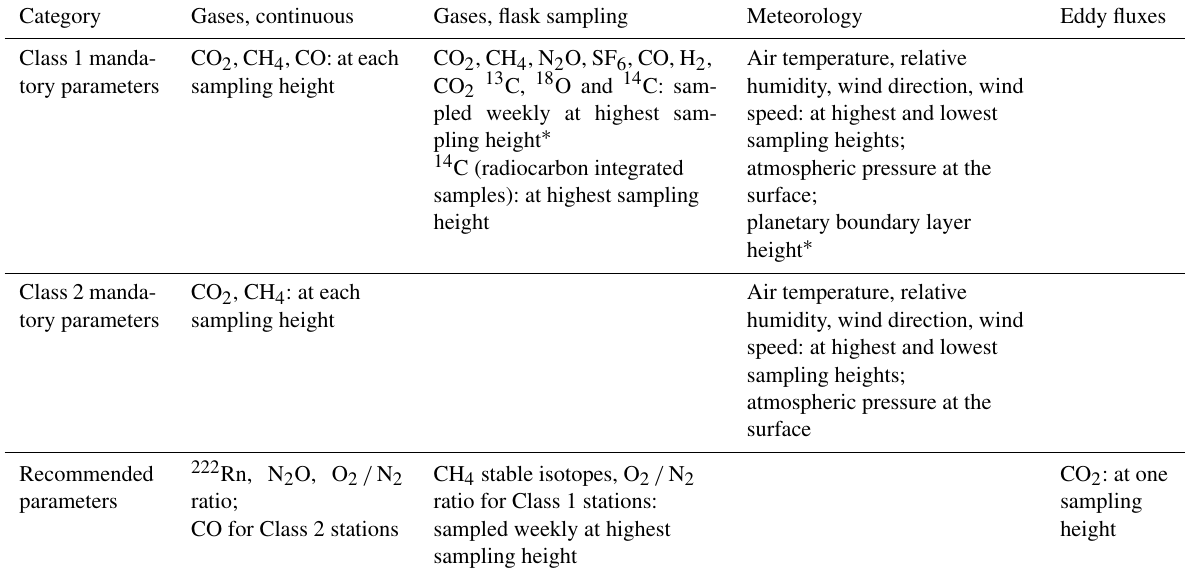
Table 1. ICOS atmosphere station parameters (from the ICOS atmosphere station specifications; ICOS RI,